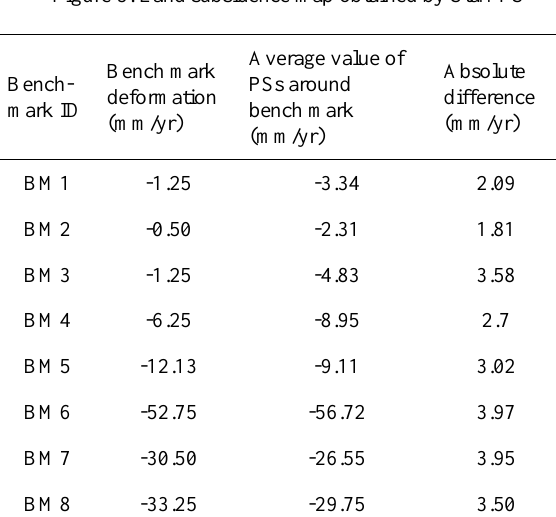
Figure 3. Land subsidence map obtained by StaMPS